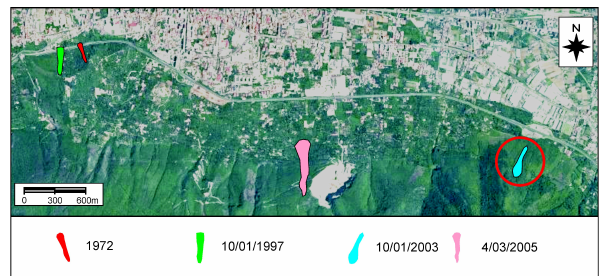
Fig. 3. Locations of debris-flow events affecting the slope of Mt. Sant’Angelo over the past 35 years. The red circle highlights the landslide considered in this paper.